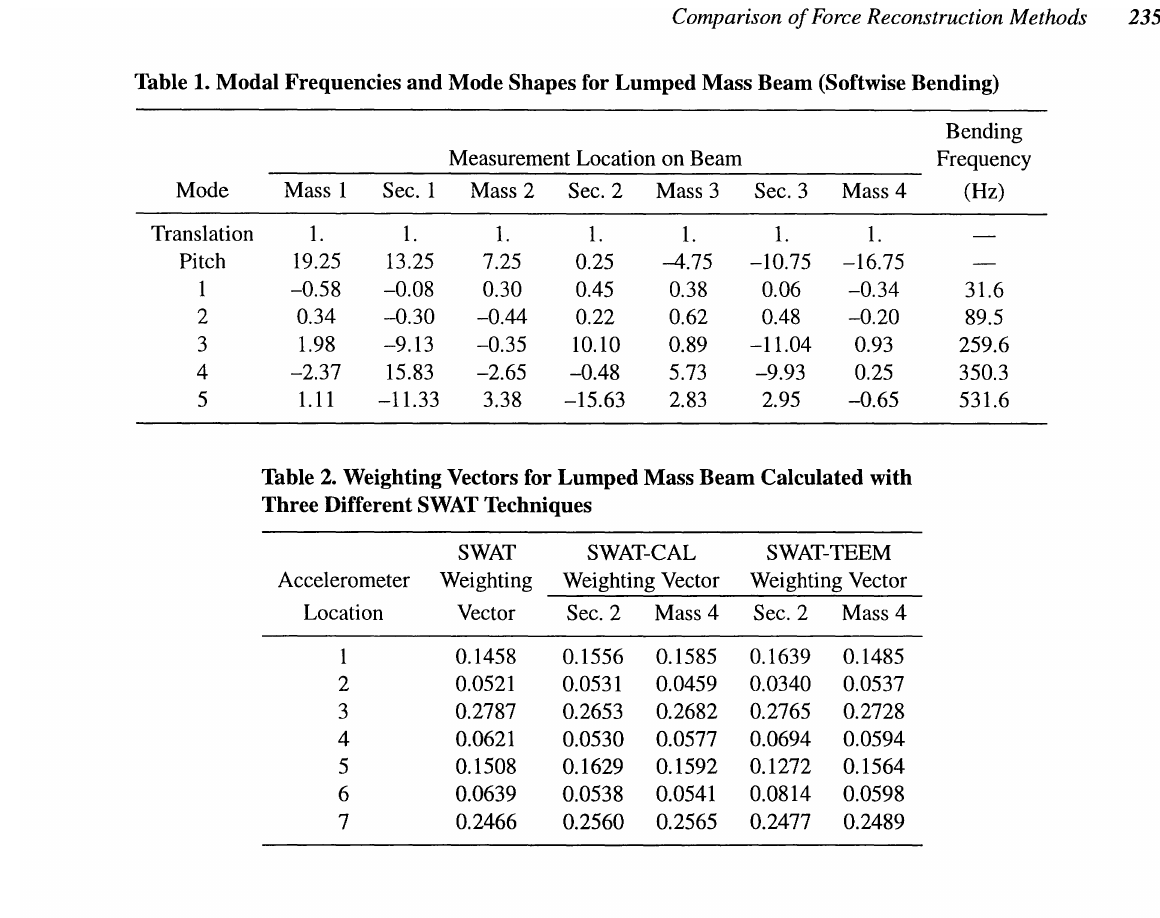
Table 2. Weighting Vectors for Lumped Mass Beam Calculated with Three Different SWAT Techniques SWAT SWAT-CAL SWAT-TEEM Accelerometer Weighting Weighting